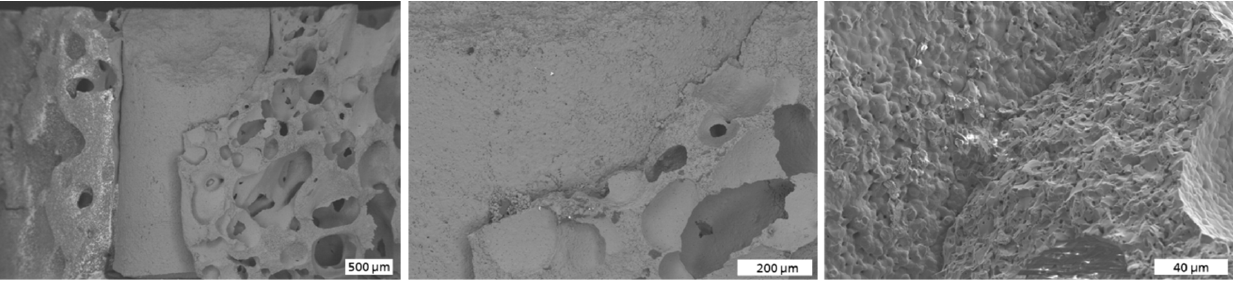
Figure 7. SEM fractured view of gap interface of VPP column and Freeze Foam: magnification/HFW 26×/4446 μ m ( left ); 100×/1109 μ m ( middle ); 500×/227 μ m ( right ); 6 kV acceleration voltage.